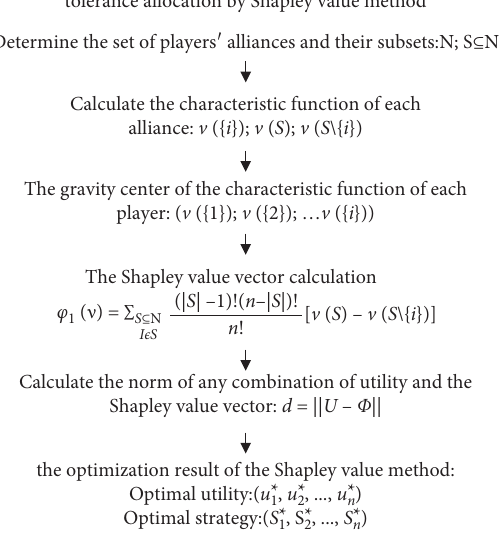
Figure 2: The process of solving the game model of the steam turbine tolerance allocation by Shapley value